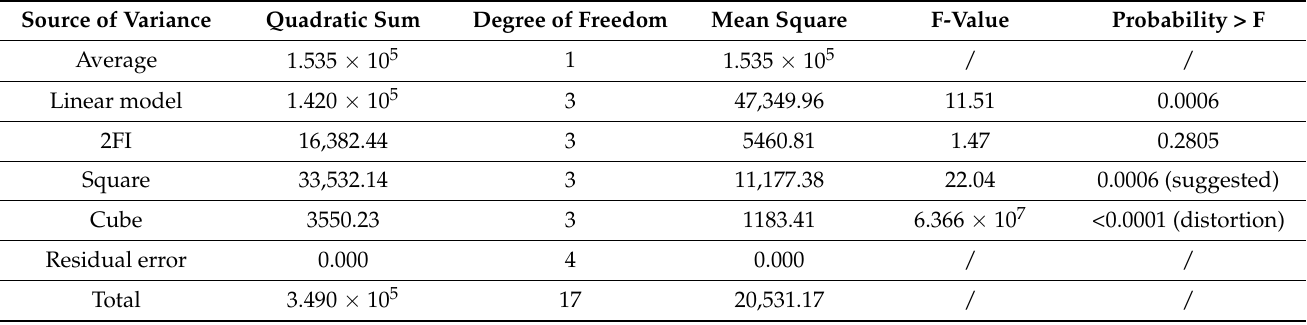
Table 9. Variance analysis and comparison of multiple